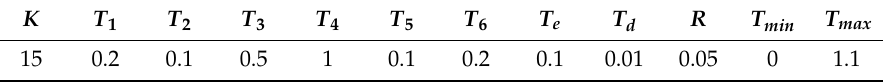
Table 4. Coe ffi cients of the DEGOV1 model